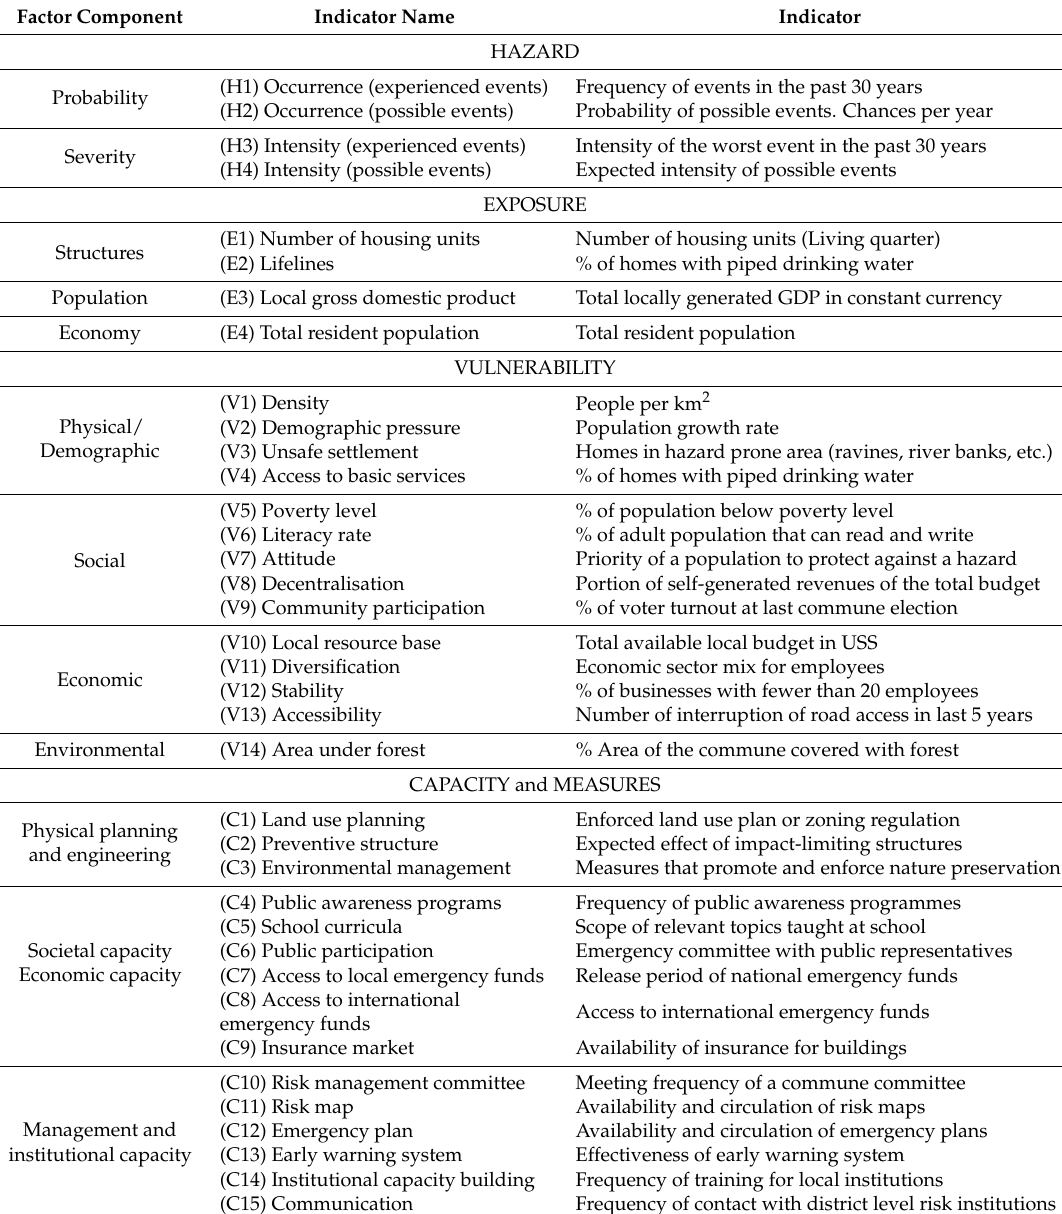
Table 2. The selected factors and indicators used in the analysis (modified from Bollin et al. [12]). Factor